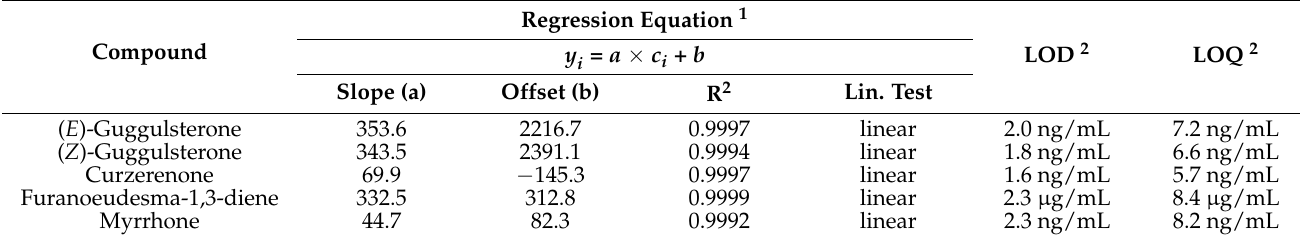
Table 1. HPLC-MS/MS validation data: Regression equation, limit of detection (LOD), and limit of quantification (LOQ).